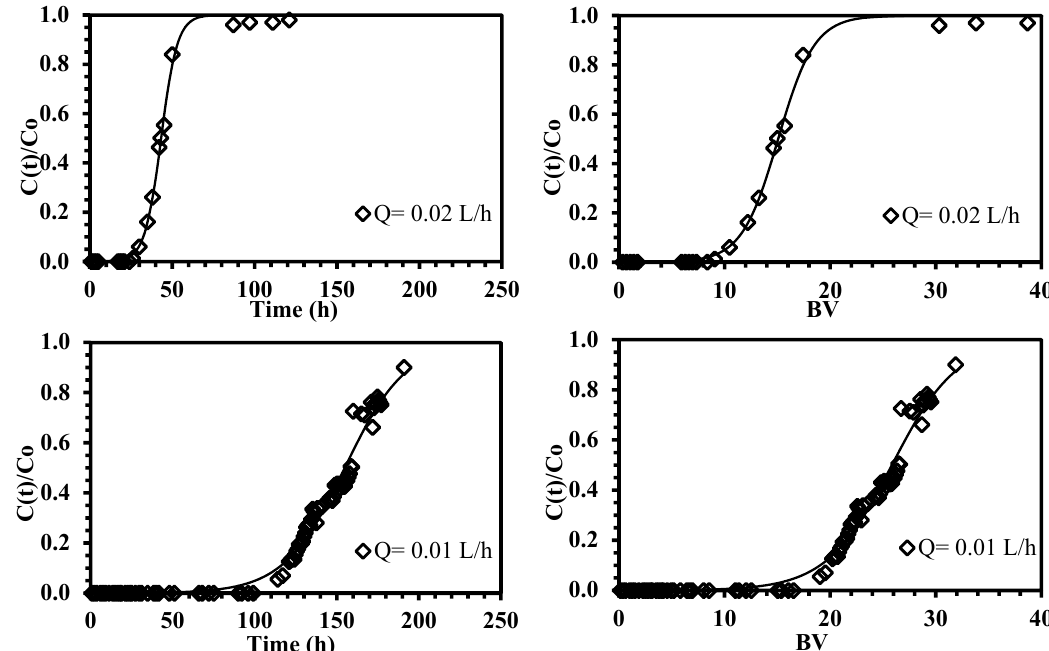
Figure 7. Continuous sorption of neodymium using ChiFer(III) material as fixed ‐ packed sorbent. (Left side: Breakthrough curves as a function of time; right side: Breakthrough curves as a function of bed ‐ volume; solid line: Thomas model; T: 20 °C; internal diameter of the column, Ø: 1.8 cm; bed depth: 23 cm; flow rate: 0.01–0.02 L ∙ h − 1 ; pH: 4; C 0 : 10.2 mg Nd(III) L − 1 ).